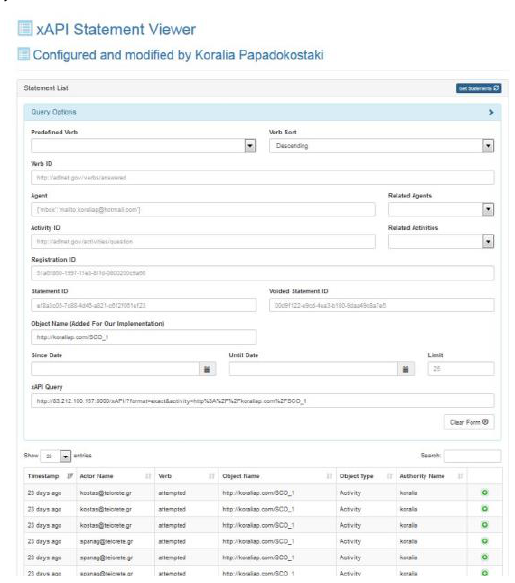
Figure 10. The xAPI Statement viewer was modified